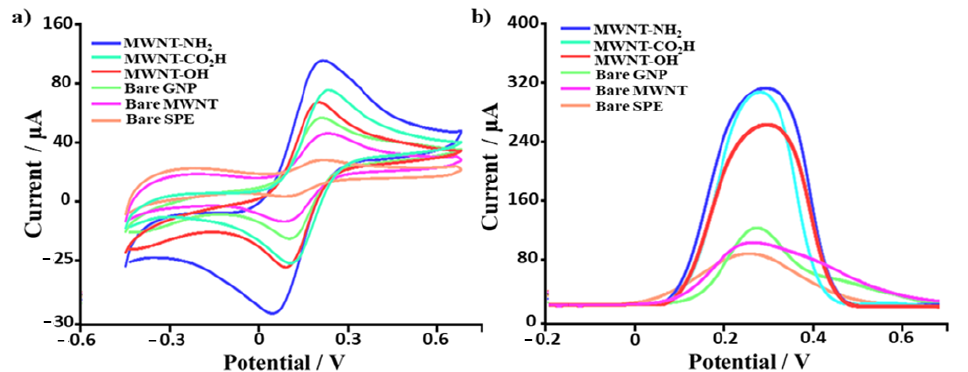
Figure 3. ( a ) Cyclic and ( b ) Square Wave voltammogram traces recorded using bare and nanomaterial-modified SPEs (GNP, Bare MWNT, MWNT-OH, MWNT-CO 2 H and MWNT-NH 2 ) in the presence of 1 mM potassium hexacyanoferrate (III) + 0.1 M KCl, pH 7.4. In ( a ), all traces were recorded at a scan rate of 30 mV s − 1 ; in ( b ), the amplitude and frequency are equal to 0.05 V and 5.0 Hz, respectively.